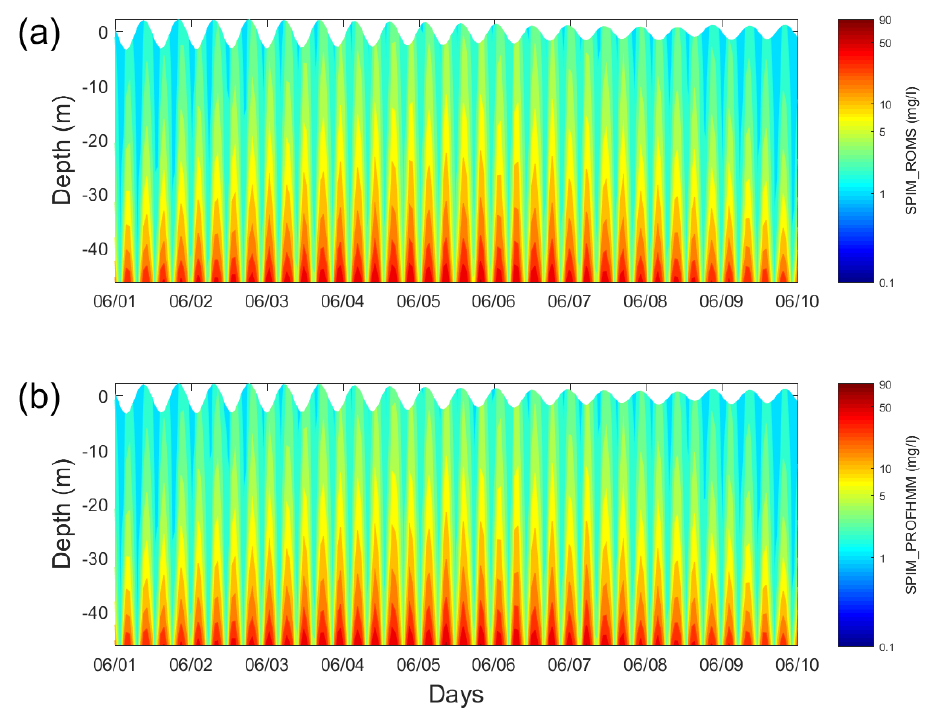
Figure 5. Learning phase of original suspended particulate inorganic matter (SPIM) section from Regional Ocean Modeling System (ROMS) data in ( a ), and corresponding PROFHMM-derived SPIM section in ( b ) from point M2 for 10-day spring tidal phase between 1 June 2008 and 10 June